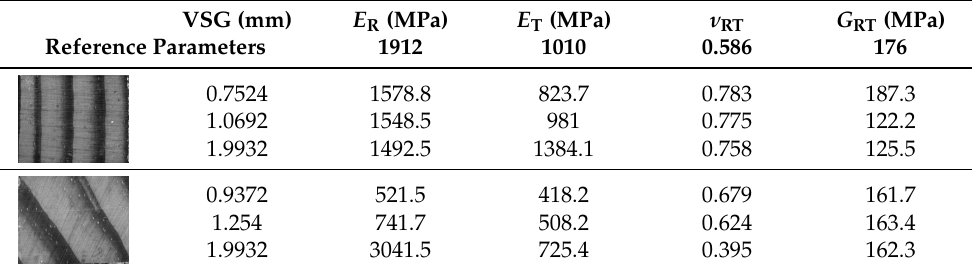
Table 6. Results from the experimental identification for an on-axis specimen and off-axis specimens, using different DIC settings and compared to the reference parameters [2,55]. VSG (mm) E R (MPa) E T (MPa) ν RT G RT